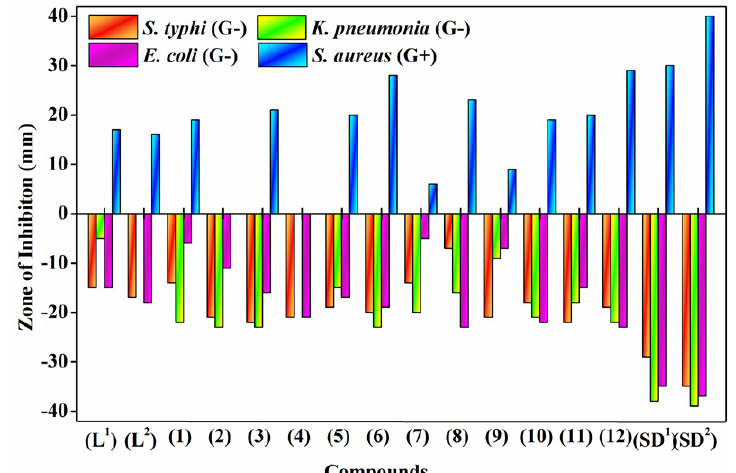
Figure 9. Antibacterial activity of phenylenediamine Schiff base derived compounds against Gram-positive and Gram-negative